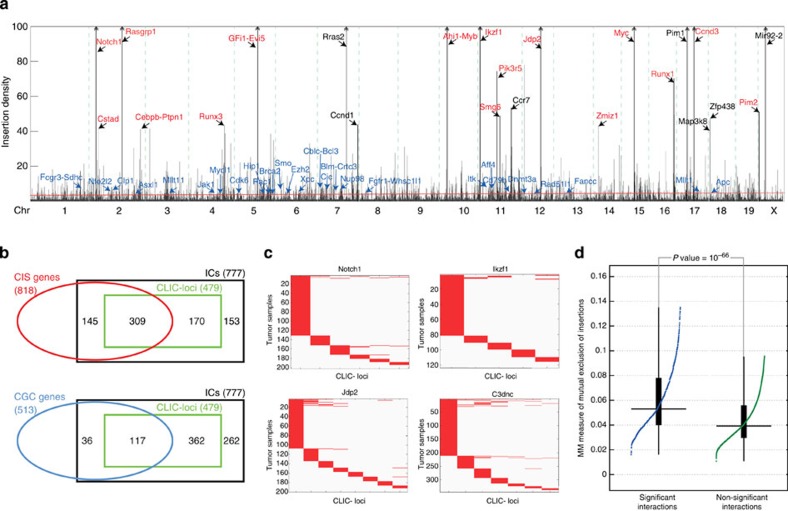
Properties of CLICs and CLIC loci.(a) Kernel-smoothed insertion count (80-kb Gaussian kernel) along the mouse genome. ICs are identified as peaks. The red line shows the median peak height (5.2), below which insertions are considered to be background insertions, that is, not contributing to tumor development. Genes associated to CISs with peak height >40 are shown (23 CISs). Among the top CISs, 19 genes that are also detected by our CLIC analysis are indicated in red. The 31 known cancer genes that are discovered as CLIC loci are indicated in blue. The insertion density in the genomic vicinity of these genes is not sufficient to be detected as CIS genes. (b) Venn diagram indicating overlap of CLIC loci with CIS and Cancer Gene Census (CGC) genes. (c) Patterns of mutual exclusive insertions in CLIC loci that form CLICs with the Notch1, Ikzf1, Jdp2 and Ccnd3 loci. A red colour indicates that an insertion occurred in the corresponding sample (y axis) and CLIC locus (x axis) (d) Boxplots of Mean-Manhattan distances between significant CLIC loci (that is, actual CLICs) and non-significant combinations of CLIC loci. This distance is defined as the fraction of samples with one of two loci inserted and captures mutual exclusivity. CLICs exhibit a highly significant (Wilcoxon rank-sum test; P value=10−66) pattern of mutual exclusive insertions.